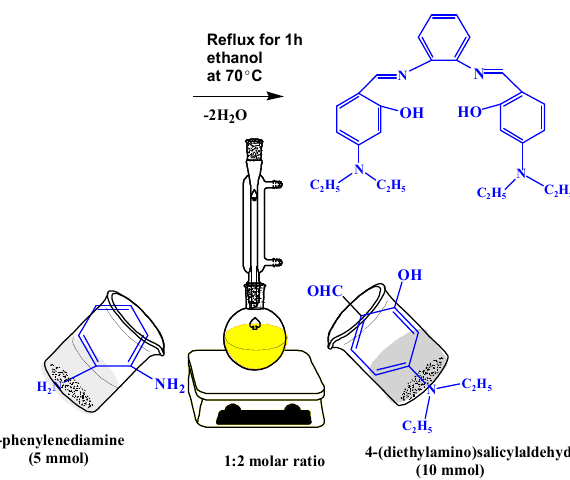
Scheme 1. Synthesis of Schiff base ligand H 2 L.